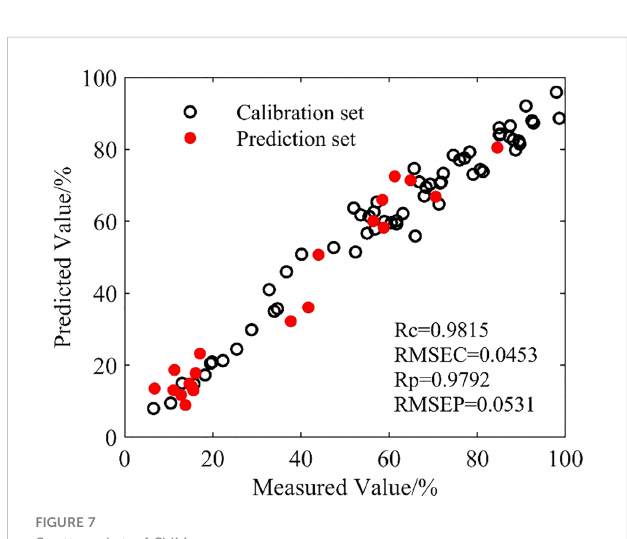
FIGURE 7 Scatter plot of SVM.